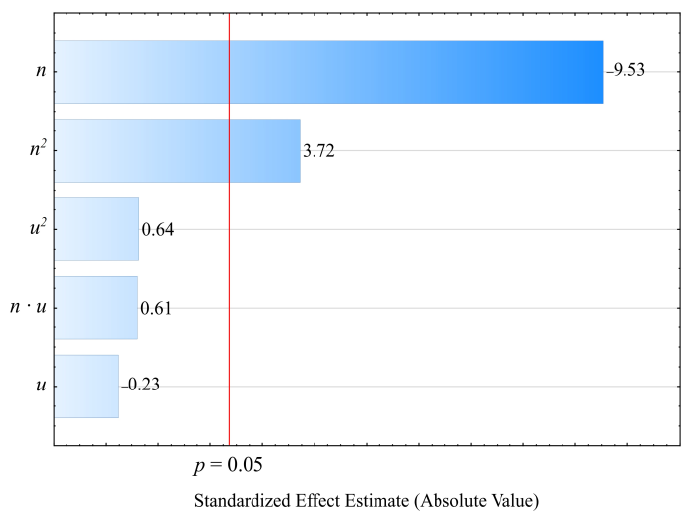
Figure 8. Pareto charts of the standardized effects for the empirical model of extruder’s specific energy consumption E jc ; the vertical line in the plot corresponds to the arbitrarily chosen level of significance ( p = 0.05).